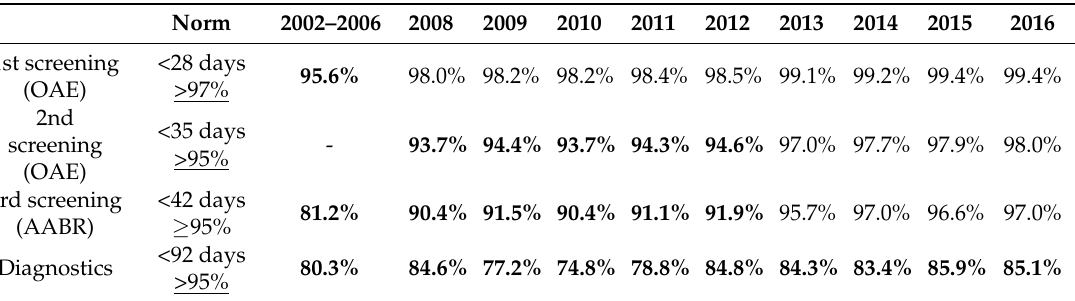
Table 3. Timeliness of screening and diagnostics 2002/2006–2016.